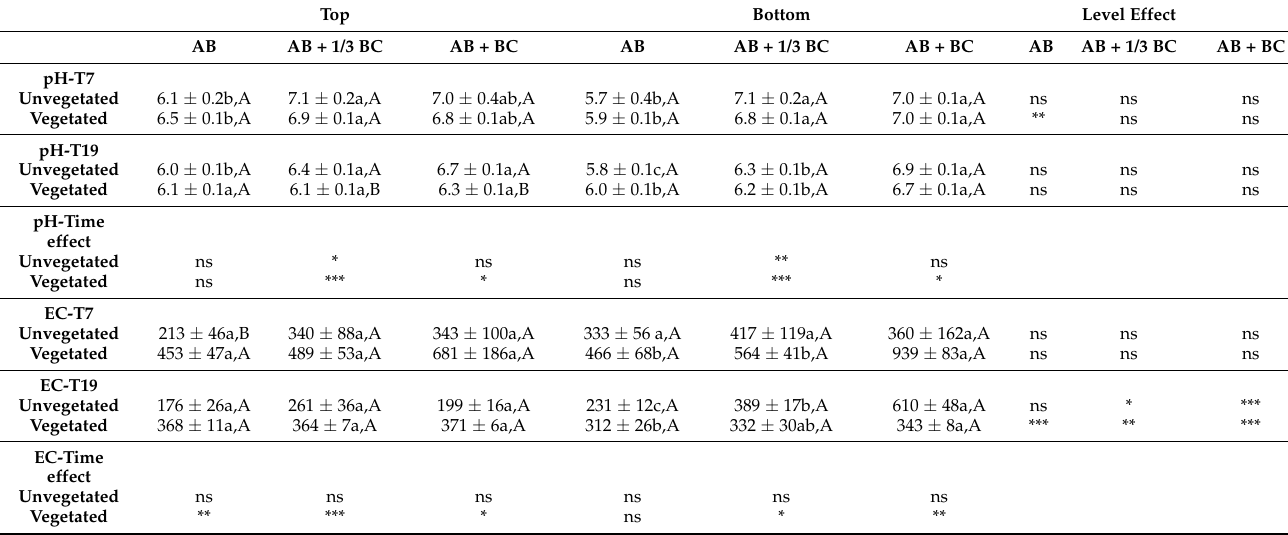
SPW pH and EC ( µ S · cm − 1 ) values are means of seven values ( ± SE), the treatment effect in the vegetated and unvegetated conditions (taken separately) is represented by the lower-case letters while the vegetation effect inside a single treatment is represented by the capital